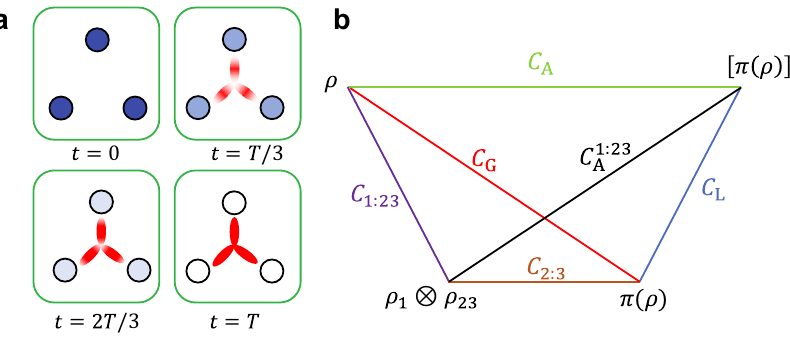
Fig. 1 Demonstration of the coherence distribution. a Quantum coherence trade-off is described in tripartite systems with circles representing the qubits. The blue discs and red leaves represent the local coherence C L and the global coherence C G . The strength of the color indicates the strength of the coherence. b A geometric picture of different coherences. Coherences are shown as distances between two different density matrices. ρ is the original density matrix; π ( ρ ) and [ π ( ρ )] d are as described in (5); ρ 1 ¼ tr 2 ; 3 ρ and ρ 23 ¼ tr 1 ρ are the reduced density